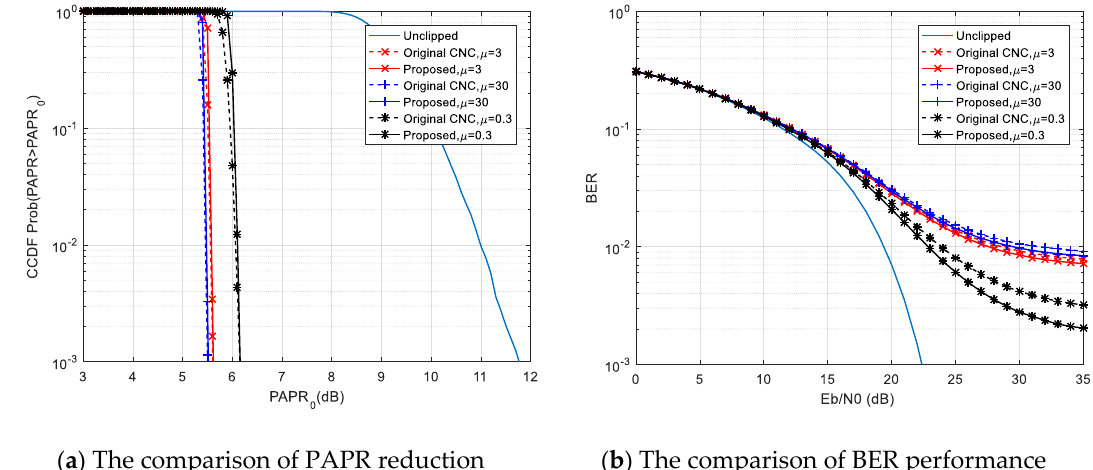
Figure 6. The CCDF probability of PAPR and the BER performance of the original CNC method and the proposed method with µ = 3, 30, 0.3, and α = 0.014, 0.015, 0.013 correspondingly, when N = 1024, M = 256, and γ = 1.8.